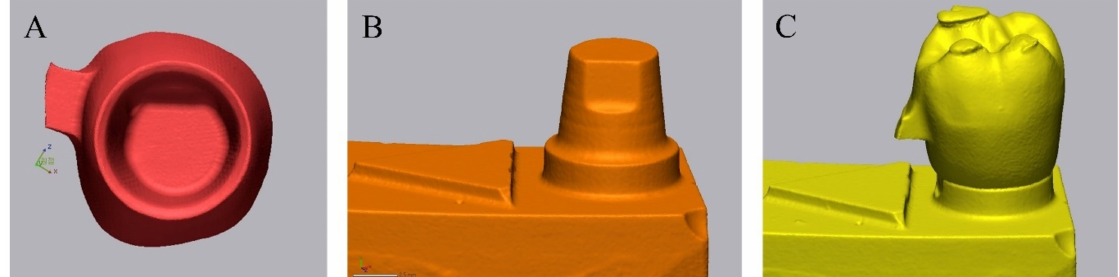
Figure 4. Triple scanning. ( A ) Crown intaglio; ( B ) master die; ( C )